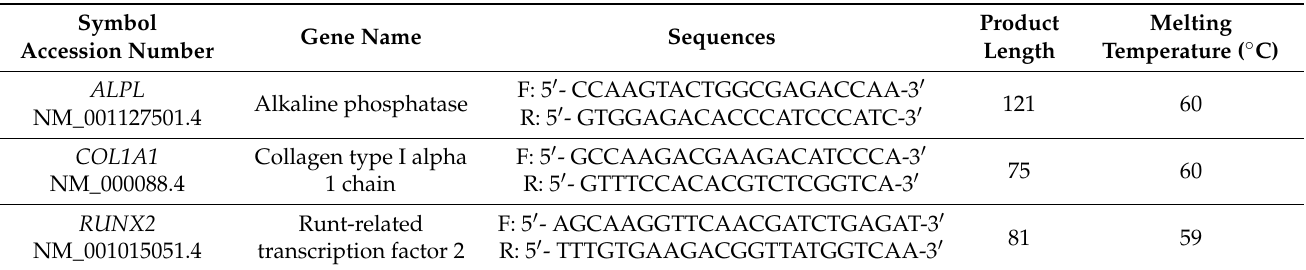
Table 5. Osteogenic differentiation-involved genes, their function, and the primer sequences used in this